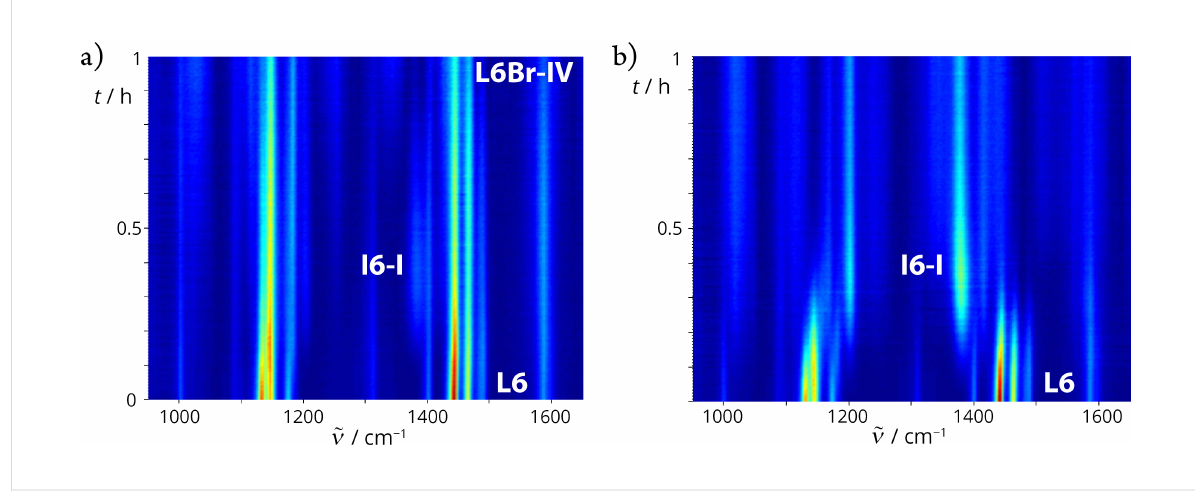
Figure 5: a) In situ observation of I6 - I during the time-resolved Raman monitoring of LAG of L6 (0.50 mmol) with NBS (0.6 mmol), TsOH (0.25 mmol), Pd(OAc) 2 (30 mol %), MeCN (15 μ L), and SiO 2 (250 mg). b) Two-dimensional (2D) plot of the time-resolved Raman monitoring of LAG of L6 (0.40 mmol) with Pd(OAc) 2 (0.42 mmol), TsOH (0.42 mmol), MeCN (0.48 mmol, 25 µL), and SiO 2 (250 mg). Only Raman spectra before fluorescence are shown in both parts.